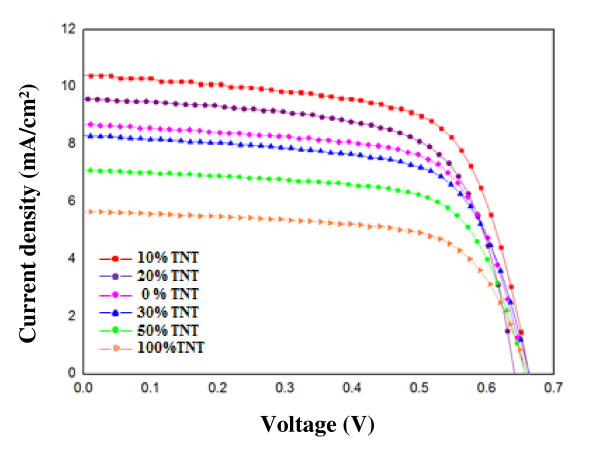
I-V characteristic of DSSC using hybrid TiO2/TNT films.